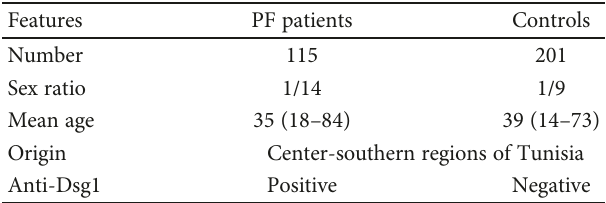
Table 1: Characteristics of study